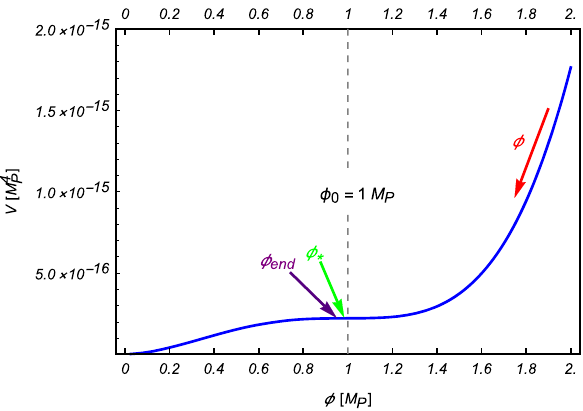
Fig. 1 Inflaton potential with a near inflection point at φ = φ 0 = M P with β > 0. The inflaton rolls from some high scale and then crosses φ φ rolls to the regime with φ ∼ φ (cid:3) , the seeds (due to 0 . Later when quantum fluctuation of φ ) for CMB anisotropies are generated. And finally inflation ends at φ